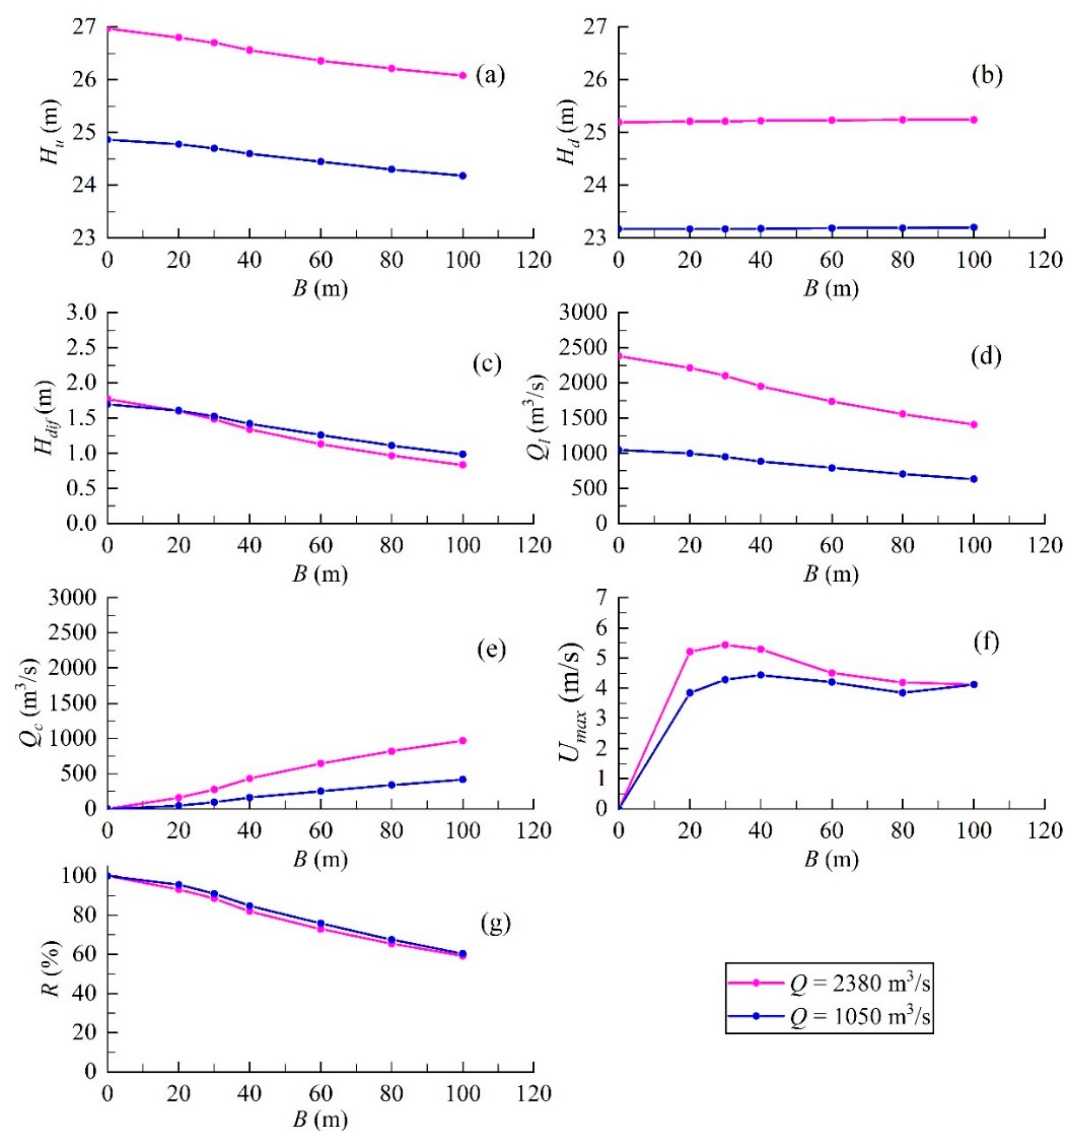
Figure 15. Numerical results of original scheme 4: ( a ) upstream water level; ( b ) downstream water level; ( c ) water level difference; ( d ) flow rate of low holes; ( e ) flow rate of closure gap; ( f ) maximum velocity; ( g ) split flow rate .